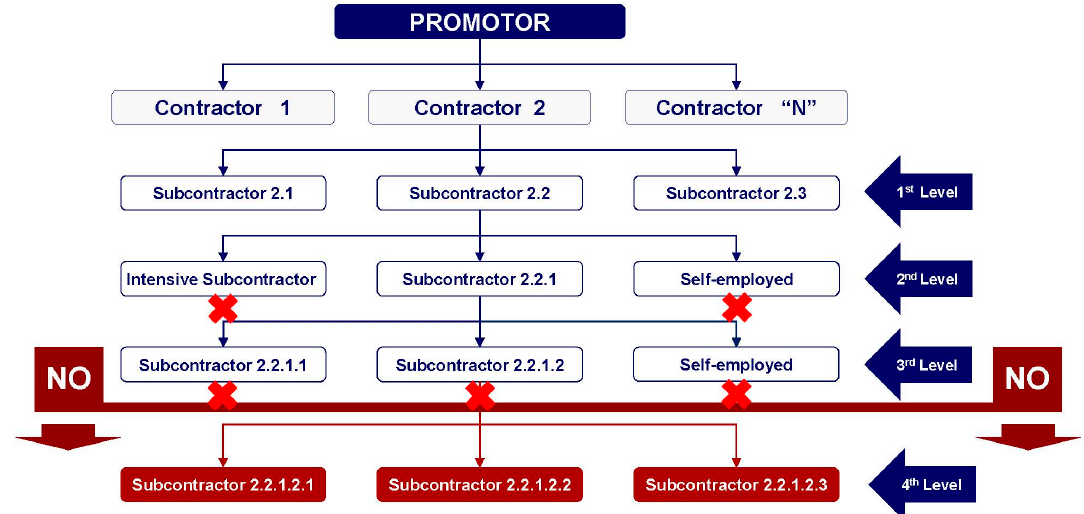
Figure 2. Restrictions on the maximum permitted levels in the subcontracting chain within construction works laid down by the Law on Subcontracting. Source: Ley 32/2006, reguladora de la subcontratación en el Sector de la Construcción [24].